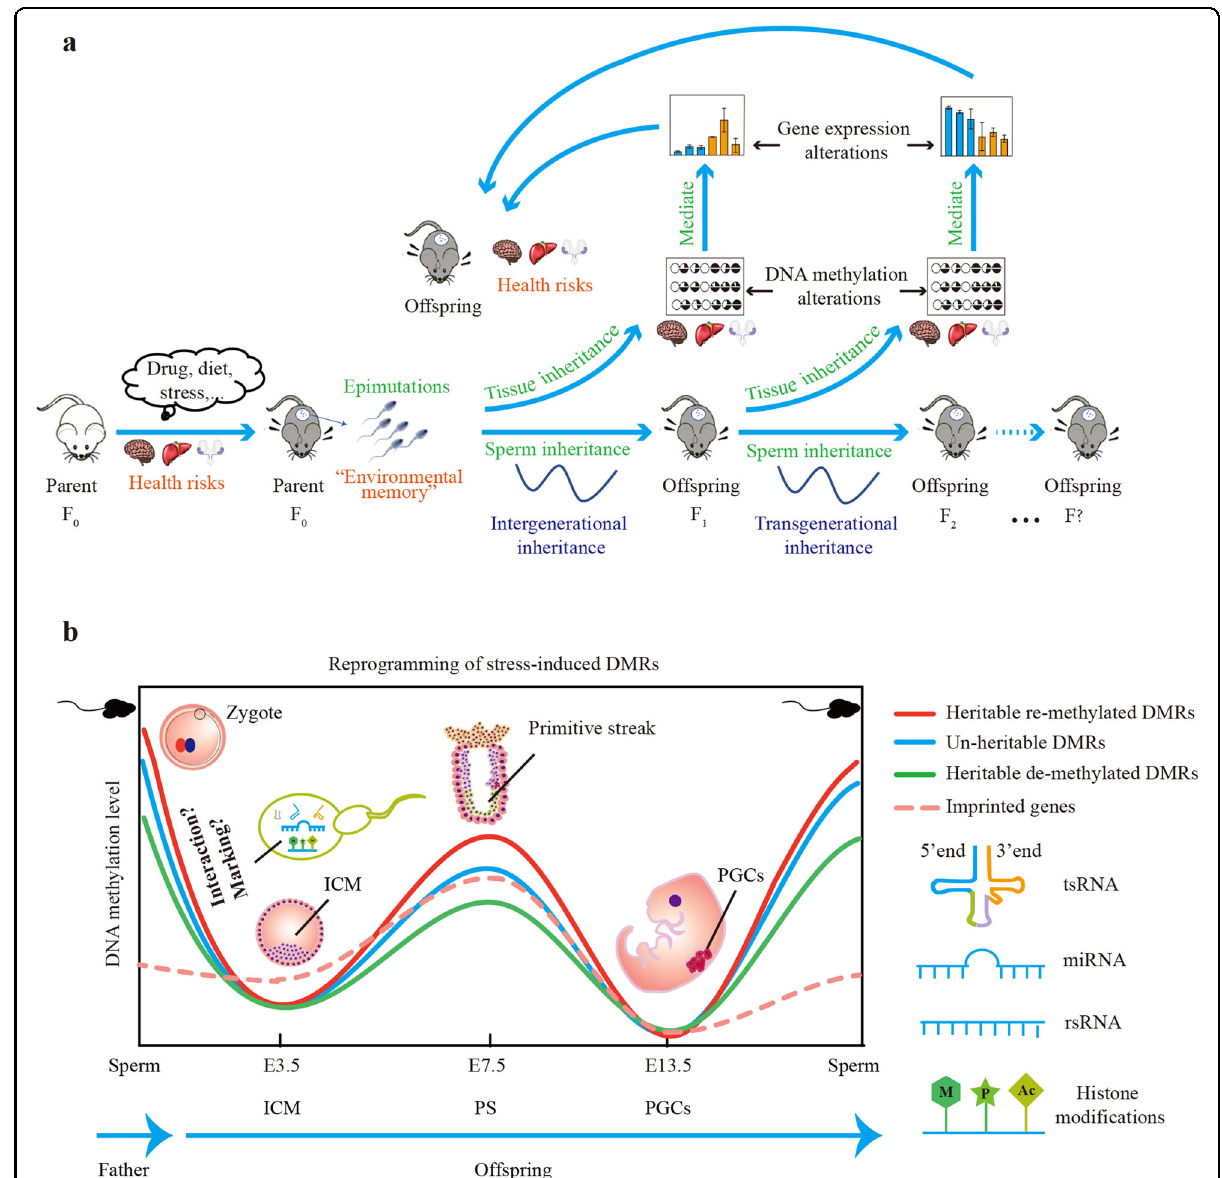
Fig. 7 A model illustrating paternal inheritance of psychological post-stress effects. a Environmental stimuli, such as long-term psychological stress, could induce health risks in male mice. Simultaneously, a lot of epimutations such as DMRs which represented “ epigenetic memory of paternal life experiences ” were stored in paternal germ cells. More importantly, notable proportions of these epimutations were epigenetically (including intergenerationally and transgenerationally) inherited by tissues as well as germ cells of the offspring. Subsequently, tissue-inherited epimutations modulated expression patterns of their related genes in relevant tissues, which in turn caused transgenerational transmission of health risks. b Most of the heritable epimutations, including re-methylated and de-methylated, were erased and subsequently reestablished, but not unaltered, during offspring embryonic reprogramming. However, their reestablishment proportions and levels in the PS stage were altered. The heritable re- methylated epimutations had higher methylation reestablishment proportion, while the heritable de-methylated epimutations had lower methylation reestablishment proportion, when compared with the un-heritable epimutations. Meanwhile, most of the heritable de-methylated epimutations had lower reestablishment levels in stress group when compared with control group, whereas most of the heritable re-methylated epimutations had higher reestablishment levels. In addition, the DNA methylation patterns of the heritable epimutations were almost fully cleared in PGCs. Thus, it is likely that some other mechanisms participated in “ marking ” the heritable status of these heritable epimutations. Histone covalent modi fi cations, such as H3K4me3 and H3K27me3, and sncRNAs, such as miRNAs and tsRNAs, can mediate inheritance of environmental-factors- induced health risks in mammals in a similar manner to DNA methylation. The roles they play in mediating psychological stress-induced paternal inheritance of health risks, through interaction with DNA methylation or marking the heritable status, require further